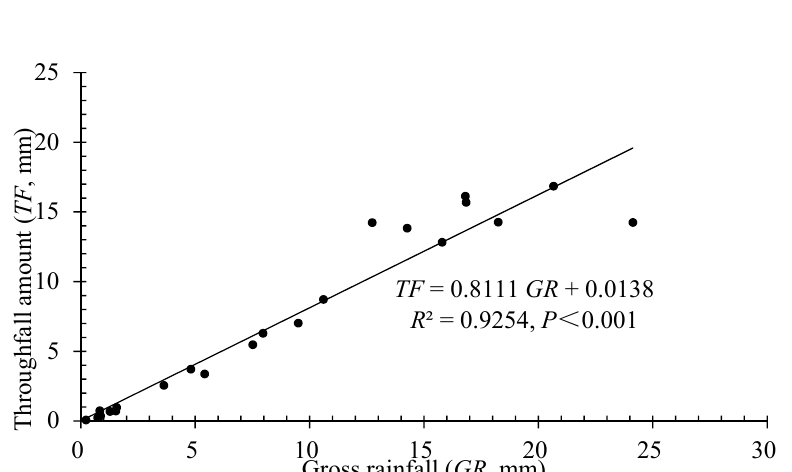
Figure 3. The relationship between gross rainfall and throughfall amount which was based on mean values from 38 throughfall collectors.